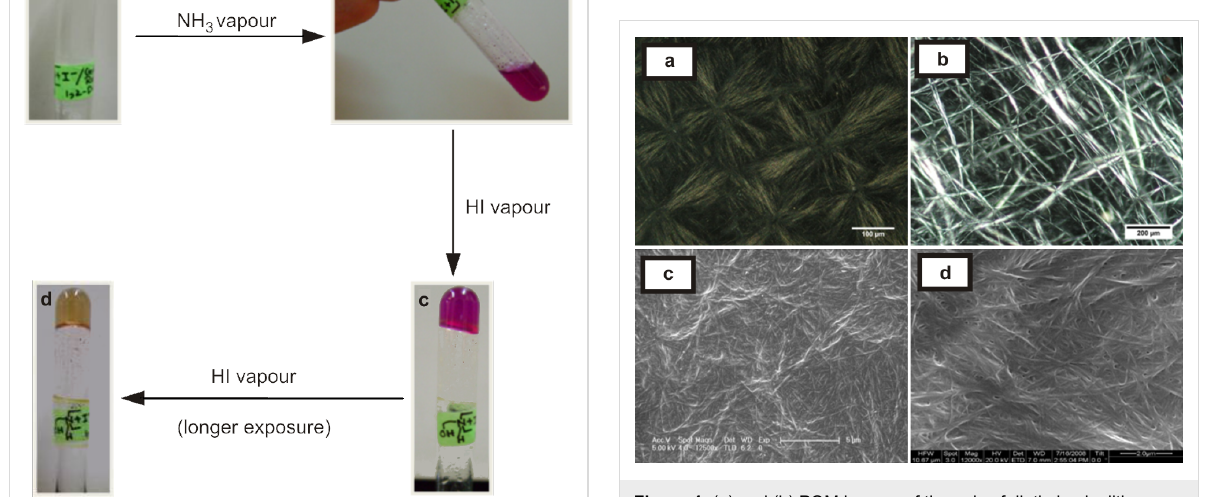
20-fold and ~0.6 equiv of acid was used with respect to the amine) was added to the gel, the gel framework was disrupted and the solution turned yellow (Figure 3b, the gel did not reform upon heating and cooling/sonication) indicating the solution has “pH” <7.2. The addition of 10 μ l of 25% aq. ammonia (13 M, ~30 equiv of ammonia was used with respect to the protonated amine) triggered the sol to gel transition and this time the gel turned pink colour (Figure 3c, heating and cooling reformed the gel).